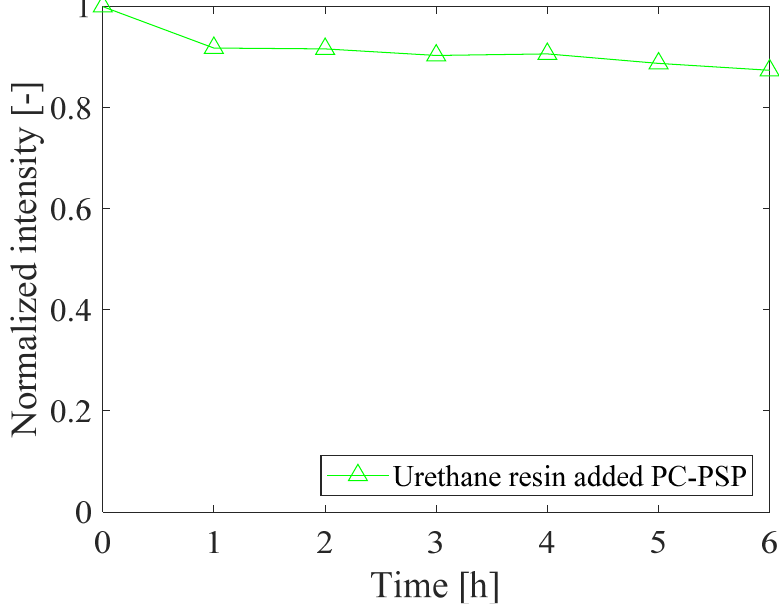
Figure 15. The thermal stability of PC-PSP with 1.0 g of urethane resin.